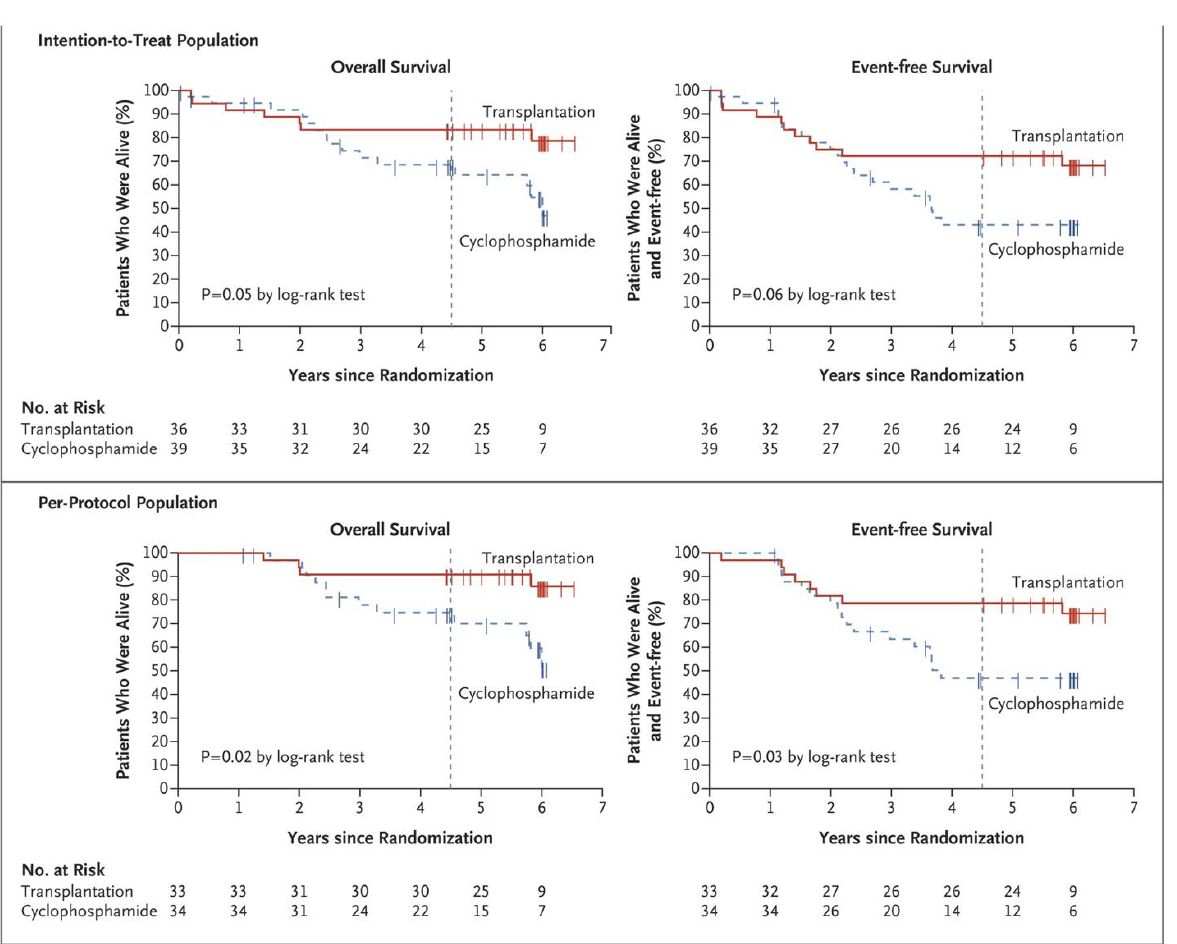
Figure 5. Survival data from the SCOT trial comparing autologous hematopoietic cell transplantation (autoHCT: red line) to conventional therapy (12 monthly doses of IV cyclophosphamide: blue line) [23]. The graphs show the overall survival and the event (organ failure)-free survival in the intention-to-treat analysis (including all participants who had undergone randomization: top ) and per-protocol analysis (including only participants who received HCT or completed ≥ 9 doses of cyclophosphamide: bottom). The vertical dashed line denotes the 54-month time point. Both overall survival and event-free survival were significantly higher in autoHCT patients in the per-protocol analysis and trended to be higher in the intention-to-treat analysis. Reproduced with permission from Massachusetts Medical Society, The New Engl. J. Med., published by Massachusetts Medical Society, 2018.